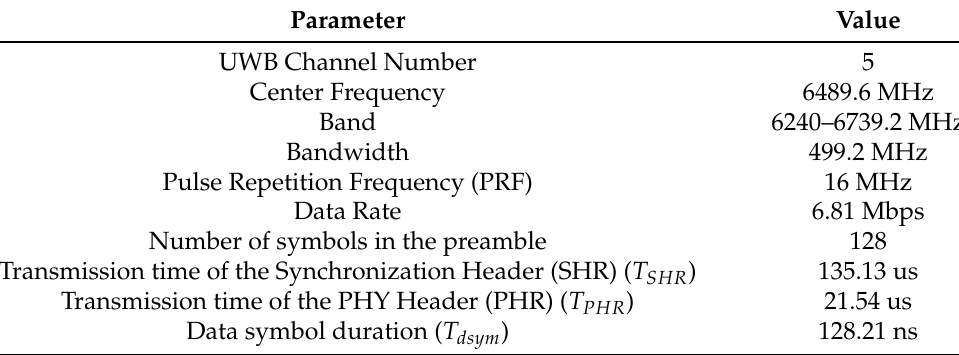
Table 2. UWB parameter